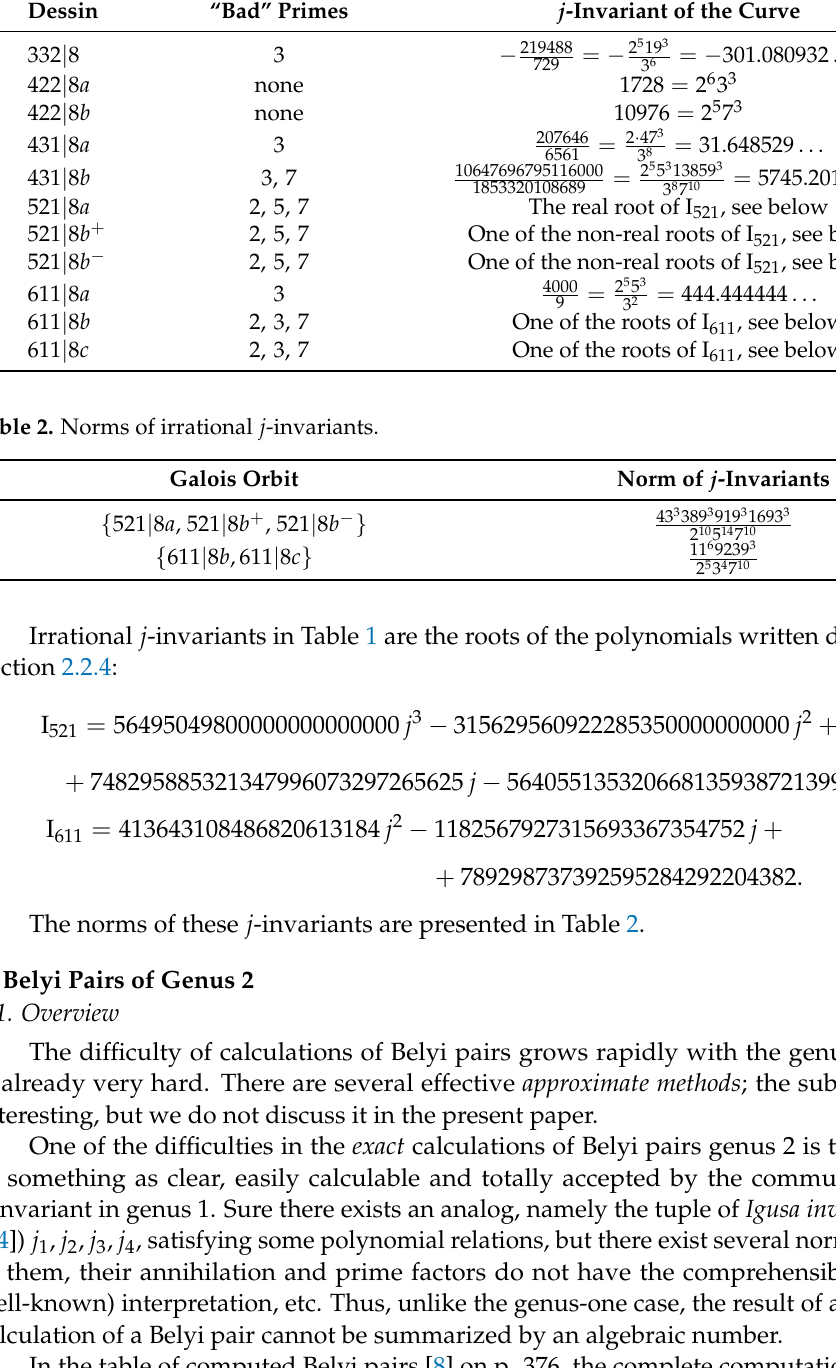
Table 1. Prime divisors of the discriminants and j -invariants of the underlying curves. Dessin “Bad” Primes j -Invariant of the Curve 332 | 8 3 − 219488 422 | 8 a none 1728 = 2 6 3 3 521 | 8 a 2, 5, 7 The real root of I 521 , see below